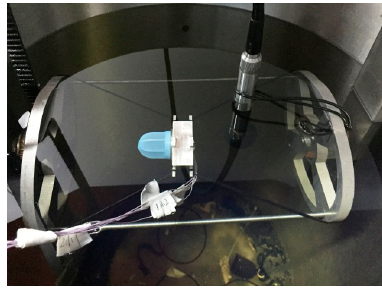
Figure 16. Standing wave tube test site.